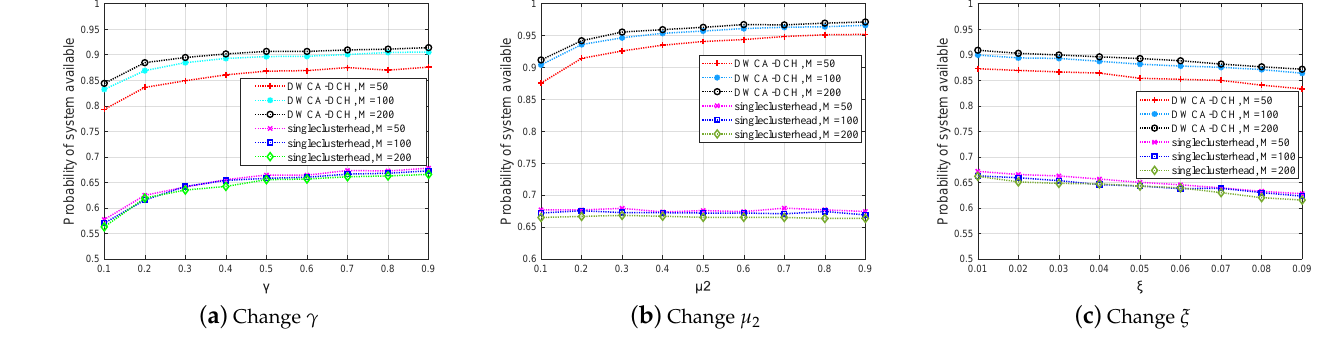
Figure 7. The variation trend of system available probability with different